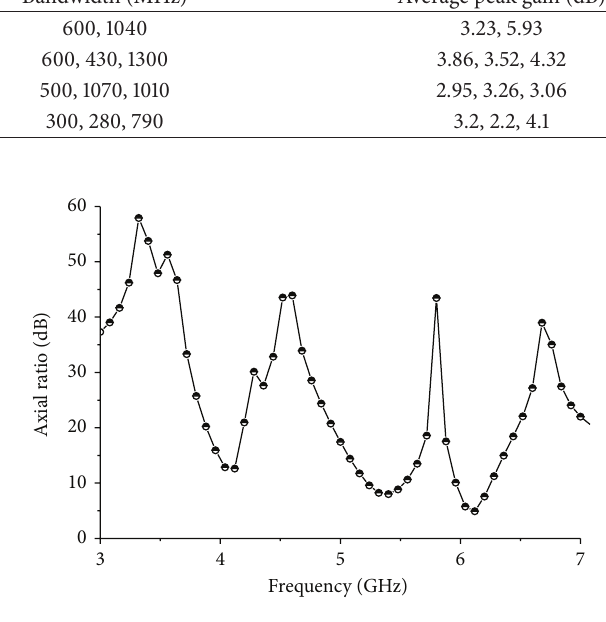
Figure 10: Axial ratio of the proposed